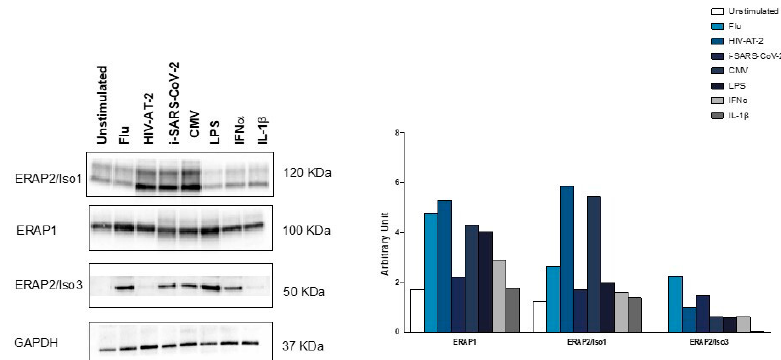
Figure 6. ERAP1, ERAP2/Iso1, and ERAP2/Iso3 production in pathogen stimulated monocyte-derived macrophages (MDMs). MDMs differentiated from 3 HeteroAB participants stimulated for 36 h with microbial antigens (flu, CMV) inactivated viruses (i-SARS-CoV-2, HIV-AT-2) bacterial by-products (LPS) or inflammatory stimuli (IFN α , IL-1 β ) were tested for protein using primary antibodies specific to (a) ERAP1 (goat polyclonal), ERAP2 (b) (c) and β -actin (d). Proteins extracted from the 3 HeteroAB subjects were sub-pooled for WB analyses. Histograms representing ERAP1, ERAP2/Iso1, and ERAP2/Iso3 densitometric quantification. Quantification was performed by Quantity One 4.6.6 software (Bio-Rad) and normalization was permed on GAPDH.